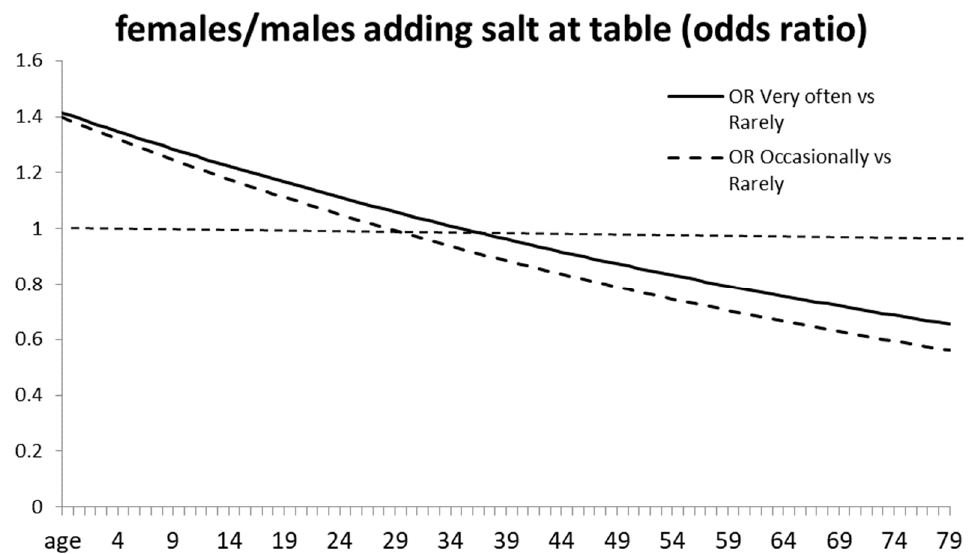
Figure 5. Odds ratios plotting responses to questions on frequency of adding salt by sex and age. Above the reference line at value 1 women salt more, below it, men salt more, so that the sex difference inverts with age. From [138].